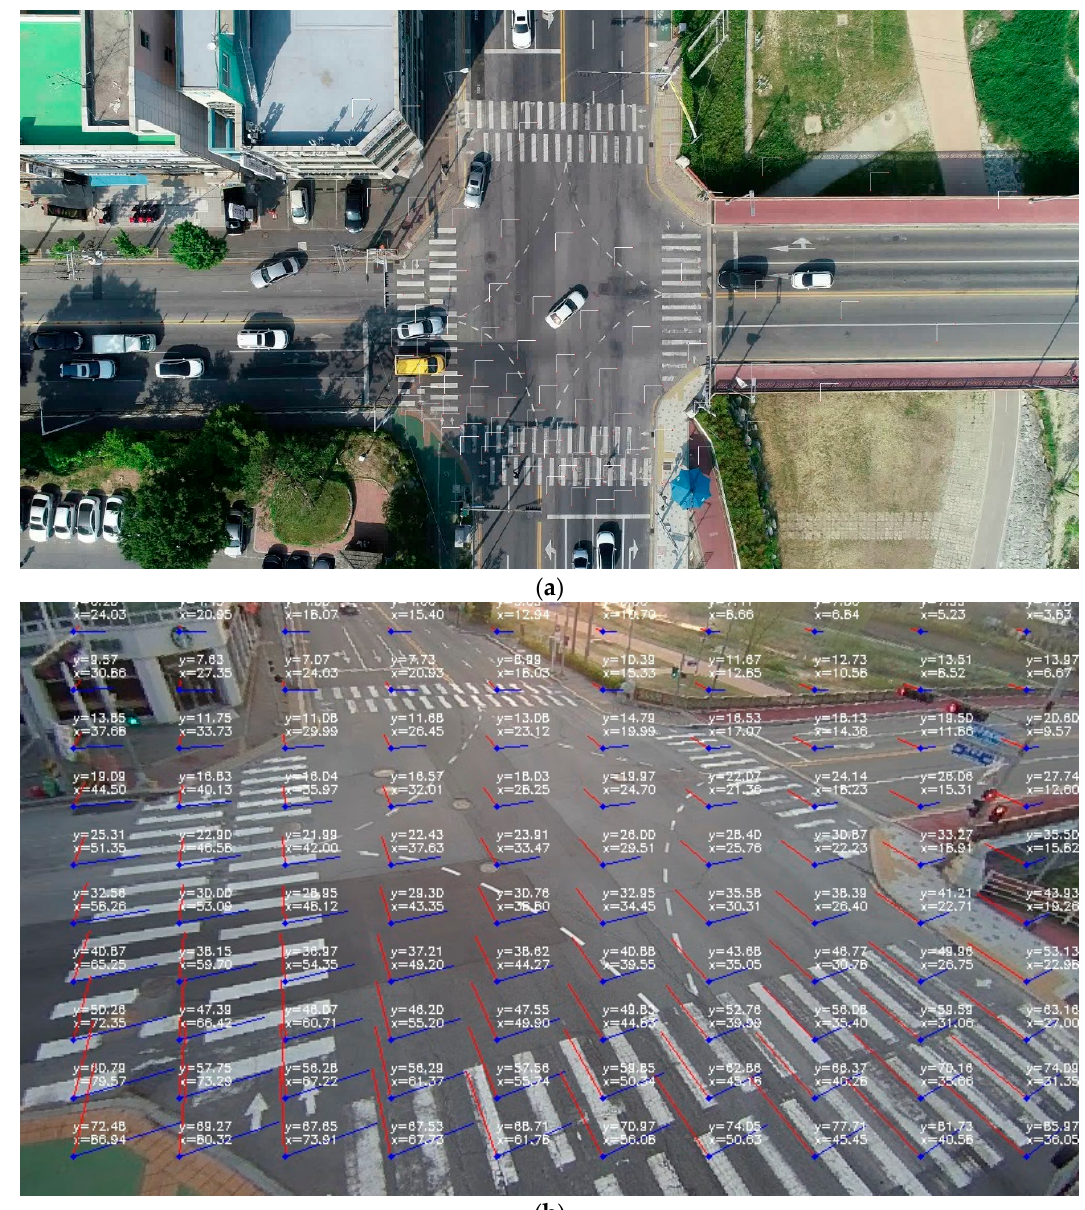
Figure 3. Reference dataset for the determination of vehicle trajectory: (a) orthophoto by unmanned aerial vehicle (UAV); (b) reference dataset.